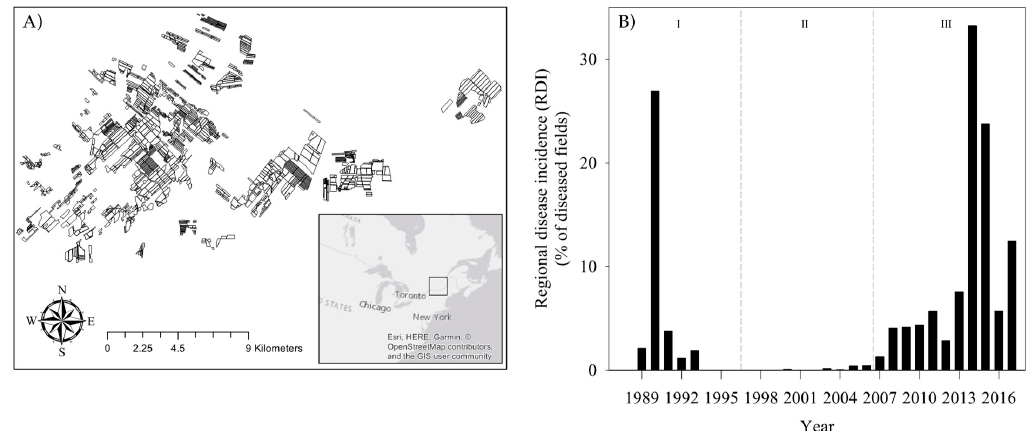
Figure 1. Location of onion fields included in the study over the years ( A ) and regional disease incidence (RDI) of onion downy mildew (ODM) epidemics observed in the Napierville County for each of the 31 years of the dataset at the end of the growing season ( B ).